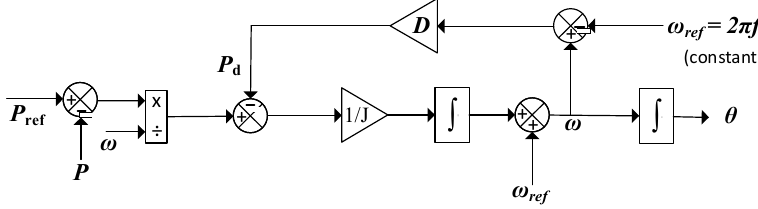
Figure 1. Basic VSG control diagram.